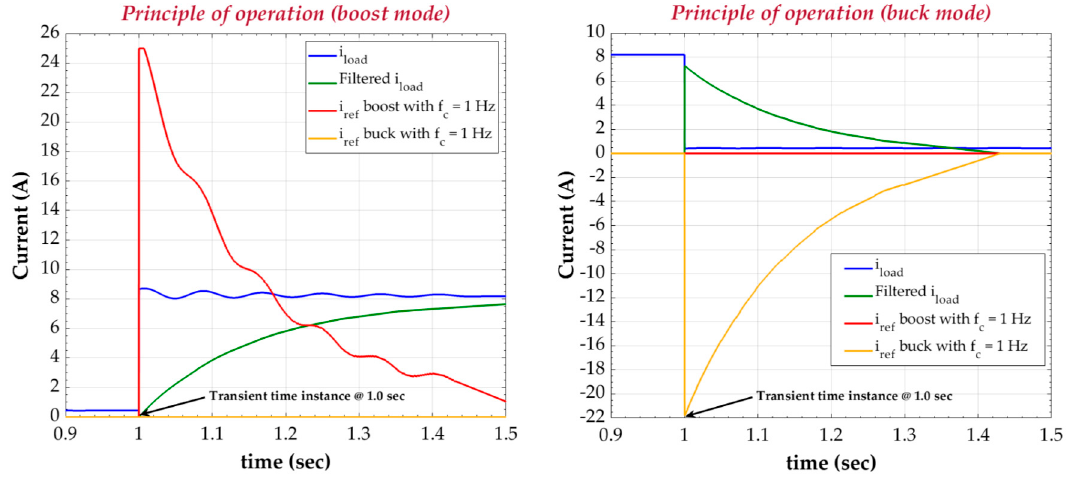
Figure 7. Principle of operation of the proposed system, for boost and buck modes.